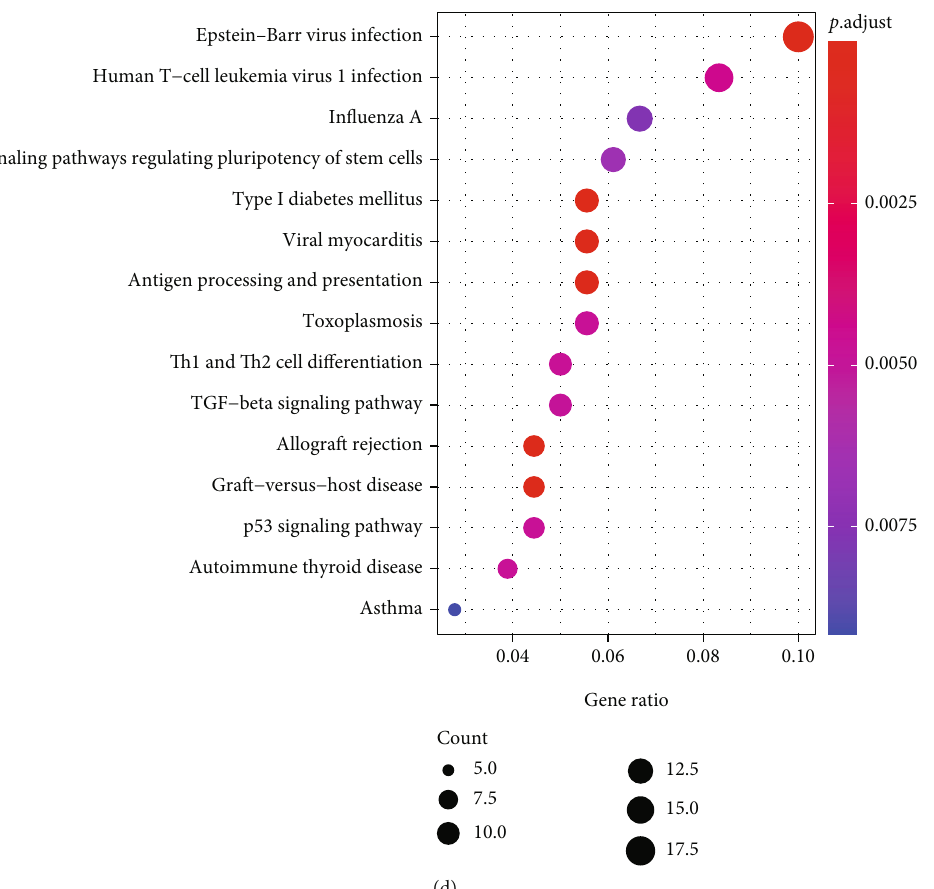
Figure 3: Functional enrichment analysis of the hyper-MR- and hypo-MR-genes. (a) GO enrichment result of hyper-MR-genes. (b) Enriched KEGG pathway of hyper-MR-genes. (c) GO enrichment result of hypo-MR genes. (d) Enriched KEGG pathways of hypo-MR